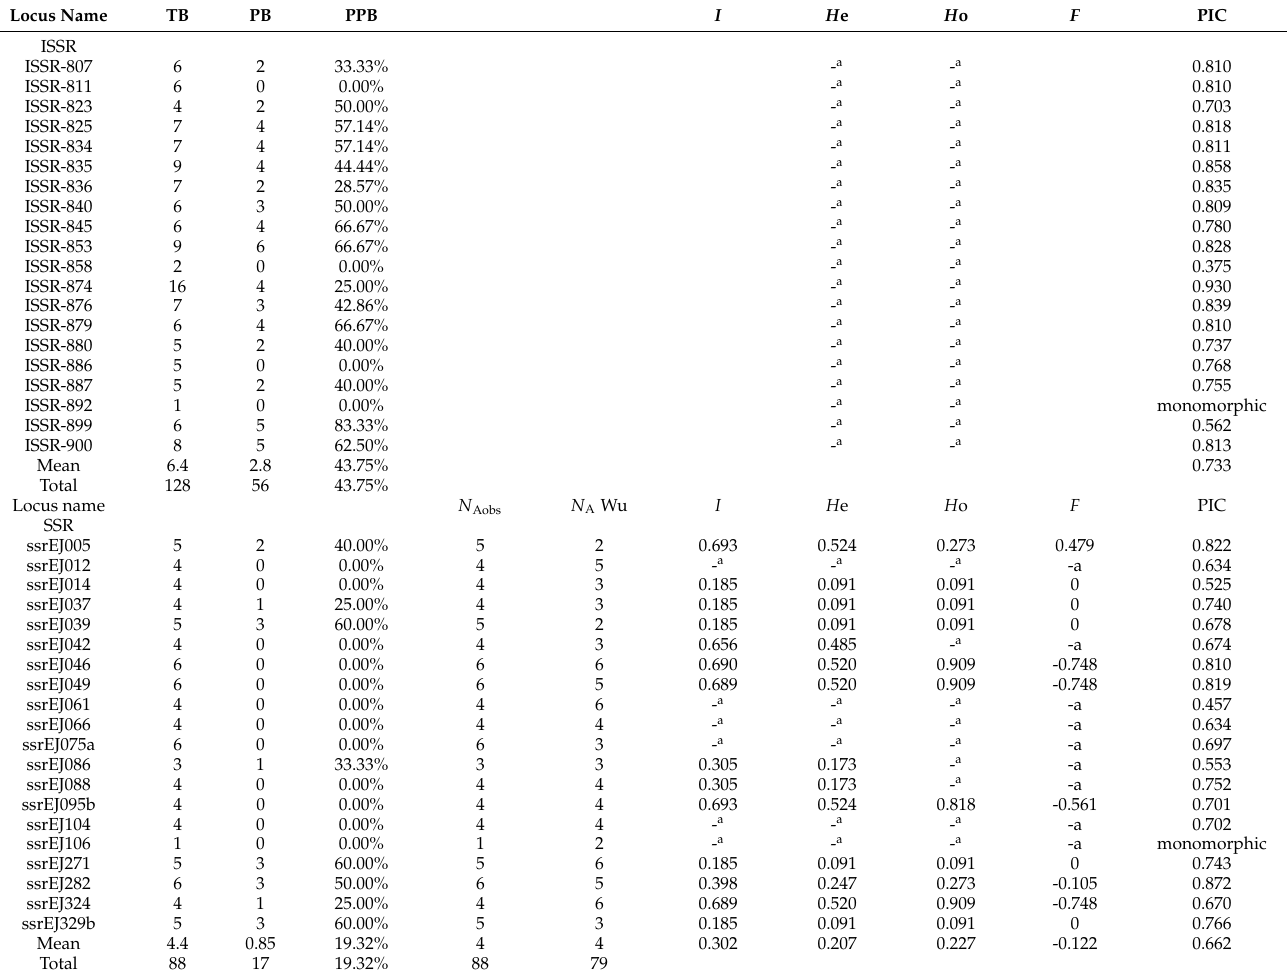
Table 1. List of the genetics parameters of the 20 ISSR and 20 SSR primers of the two cross